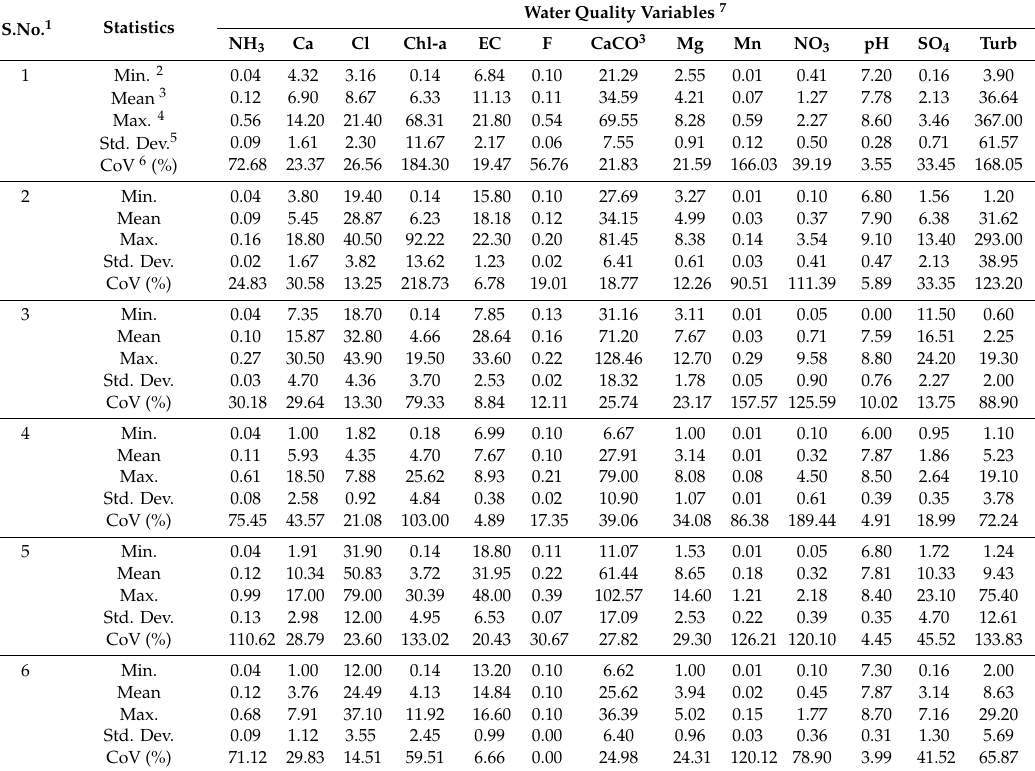
Table 2. Descriptive statistics for observed water quality data for UWB for a period ranging from 2014 to